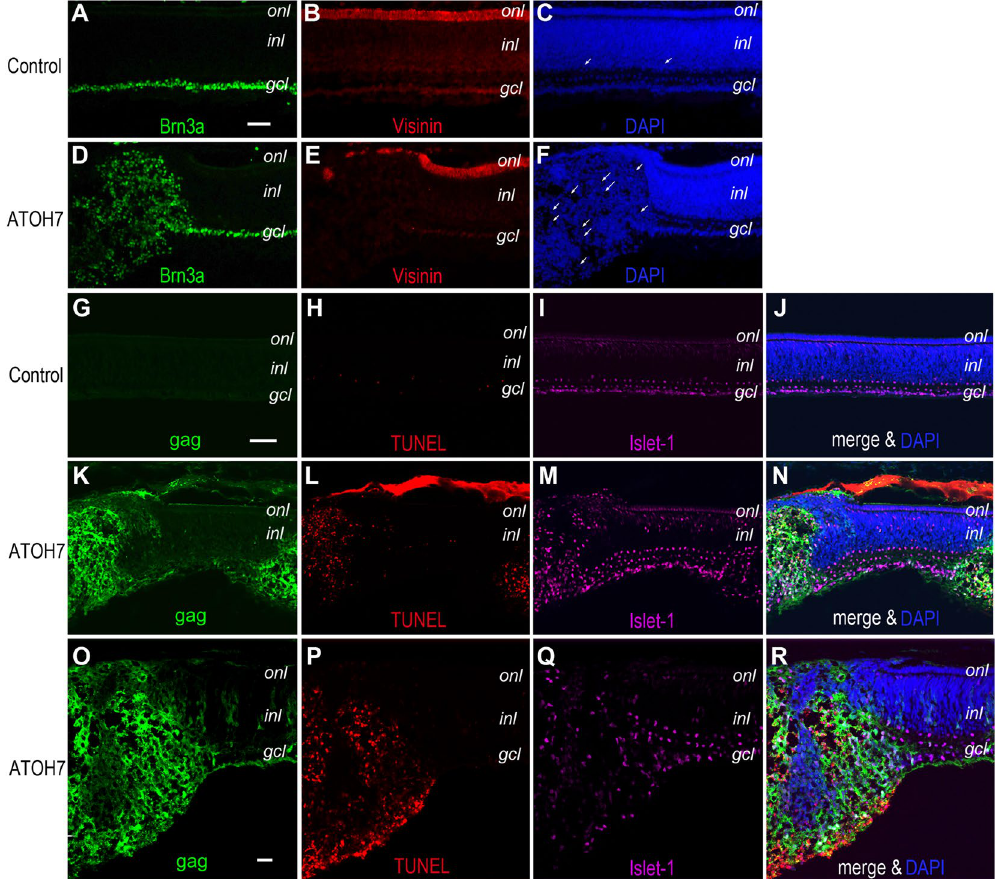
Figure 7. Influence of viral ATOH7 expression on neuronal survival. ( A – F ) Immunolabeling for neuronal markers of E9.5 retina infected at stage 17 with control virus ( A – C ) or ATOH7 virus ( D – F ). Note that ATOH7 virus infected retinas contain regions with increased numbers of RGC marker positive cells, but also disrupted lamination and extensive cell death as revealed by pyknotic nuclei (white arrows). ( G – R ) Co-labeling of TUNEL assay and cell markers. Non-infected control retina ( G–J ) contains few apoptotic cells at E9.5. ATOH7 virus infected retinas ( K – R ) show elevated TUNEL cells in gag-positive regions. Note the normal lamination and low cell death in neighboring non-infected areas. Scale bar: A (for A – F ), G (for G – N ) 20 μ m; O (for O – R ) 10 μ m. gcl , ganglion cell layer; inl , inner nuclear layer; onl , outer nuclear